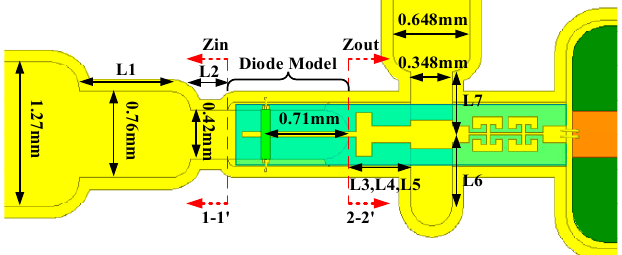
Figure 6. Design of input and output matching (L1 = 767 µ m, L2 = 318 µ m, L3 = 58 µ m, L4 = 138 µ m, L5 = 330 µ m, L6 = 622 µ m, L7 = 547 µ m).